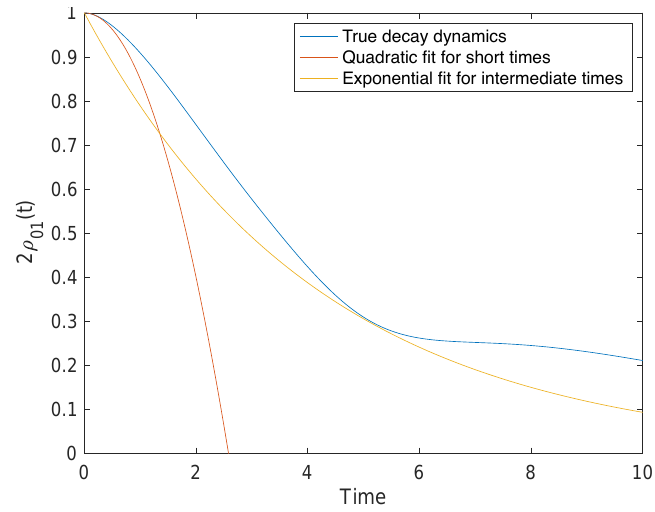
Figure 1: The model discussed in the paper induces decoherence of the off- diagonal elements of the qubit density matrix. The initial wave-function, chosen = ψ ∝ xe −| x | , is in the domain of the Hamiltonian (see Appendix). There- as ψ 1 2 fore, the decay starts quadratically (as indicated by the fit for short times). This is contrasted with an exponential (‘Markovian’) fit.